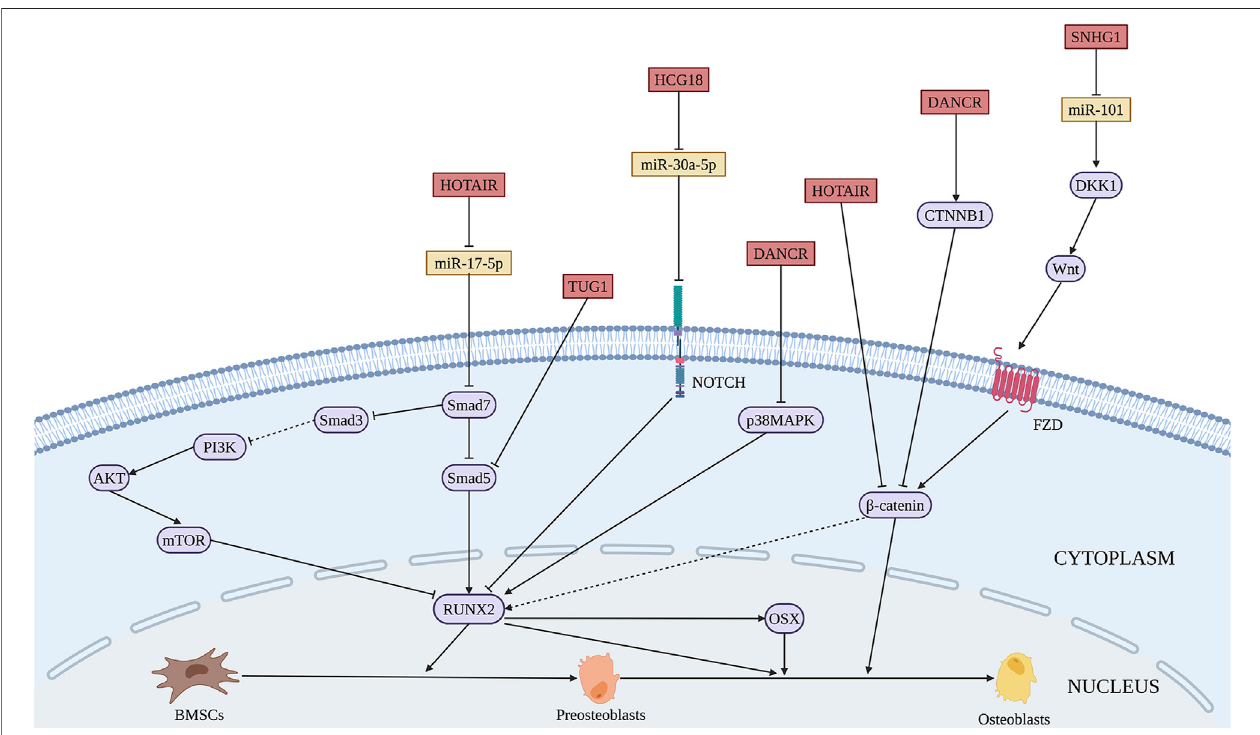
FIGURE 5 | Illustration of the role and regulatory mechanism of lncRNAs-inhibited osteogenic differentiation of BMSCs. Some lncRNAs inhibit BMSCs osteogenesis through sponging pro-osteogenic miRNAs (orange). (Created with BioRender.com).